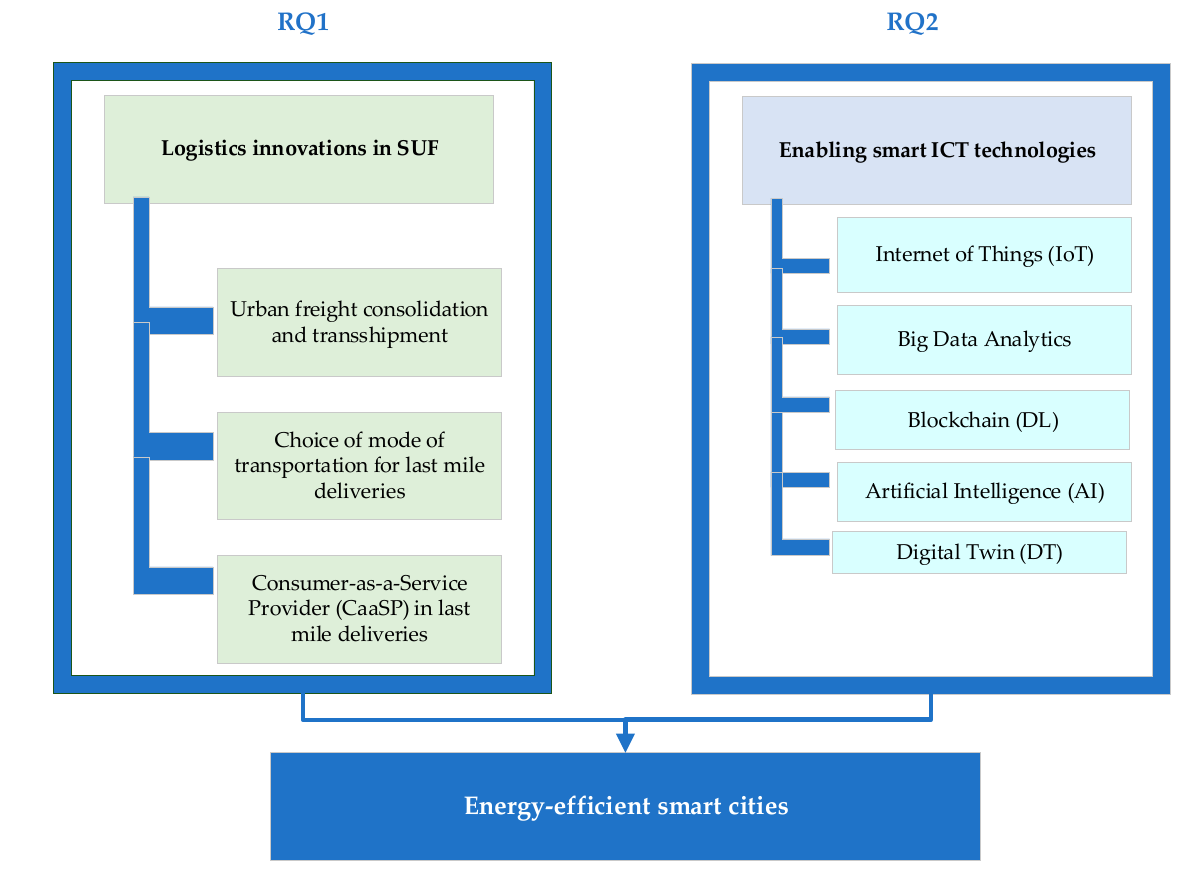
Figure 10. The summary of the thematic analysis of the dataset—macroscopic view.